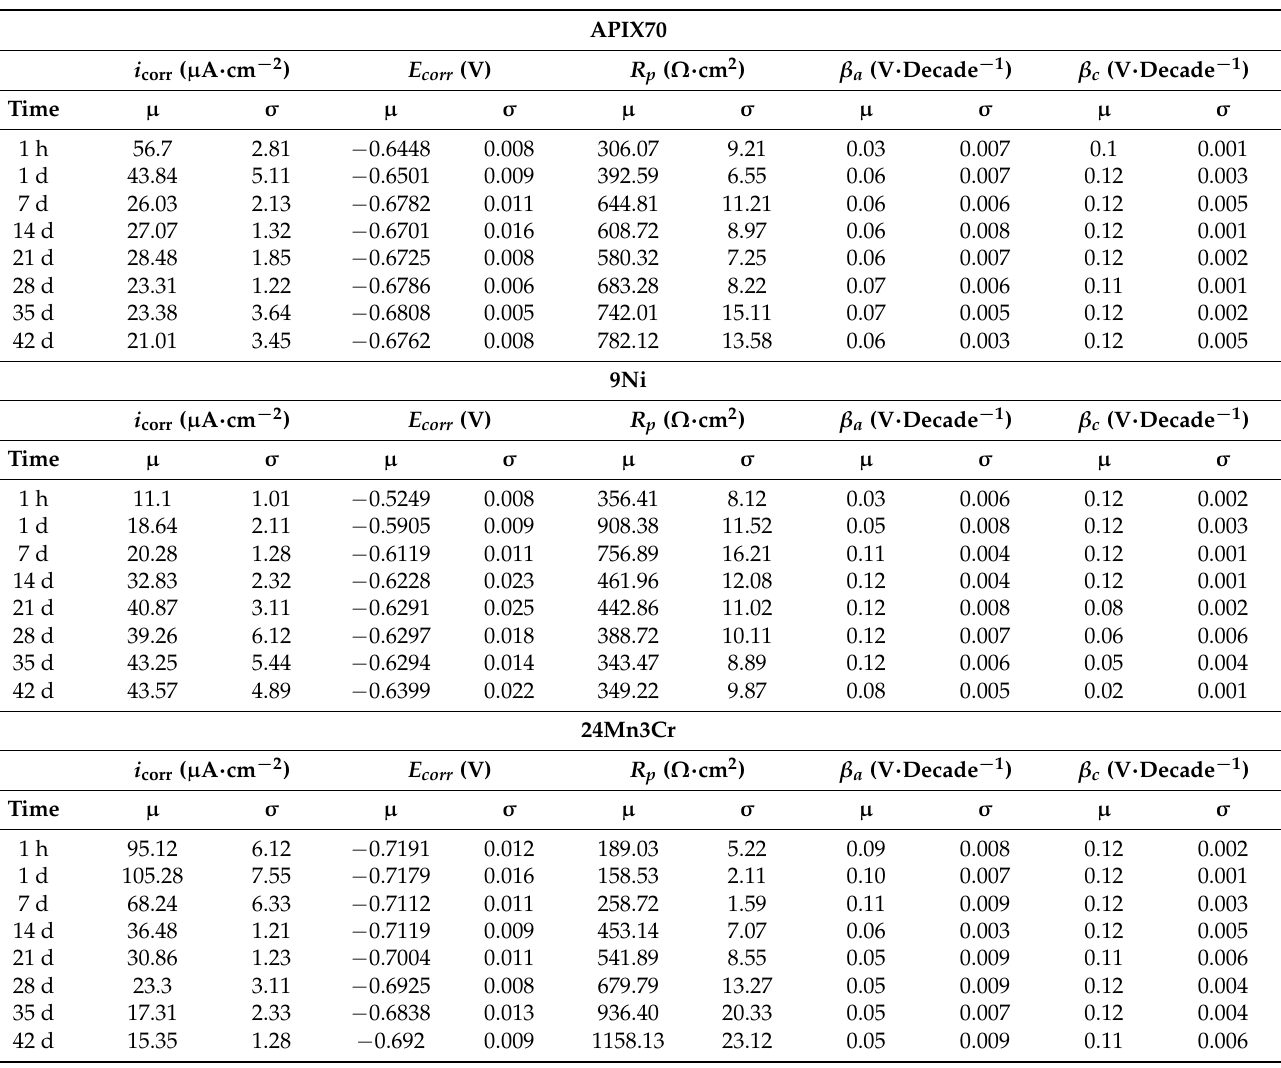
Table 2. Mean values ( µ ) and their standard deviations ( σ ) of several fitted parameters obtained by curve fitting to the LPR data of the tested samples.